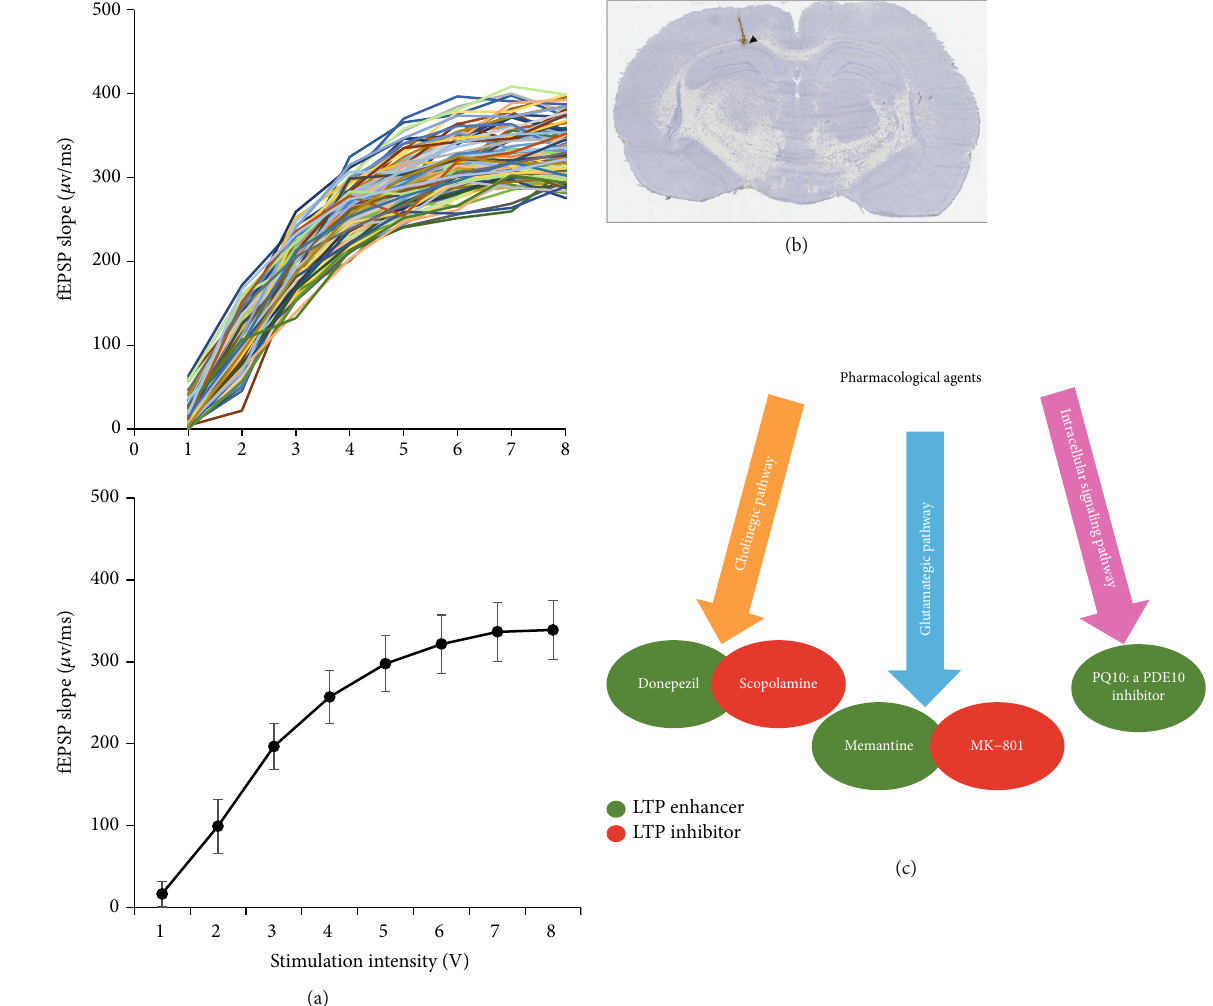
Figure 8: (a) Spaghetti plot of individual input/output curves and average values. Individual fEPSP slopes ( n = 103 ) lie between 250 μ V/ms and 400 μ V/ms at 200 μ s stimulus duration, and the calculated test stimulus fi ts between 3 V and 4 V for all experiments. Value represent mean ± SEM . (b) A representative image depicting stimulation and recording sites. (c) Pharmacological agents used to study LTP response in LE